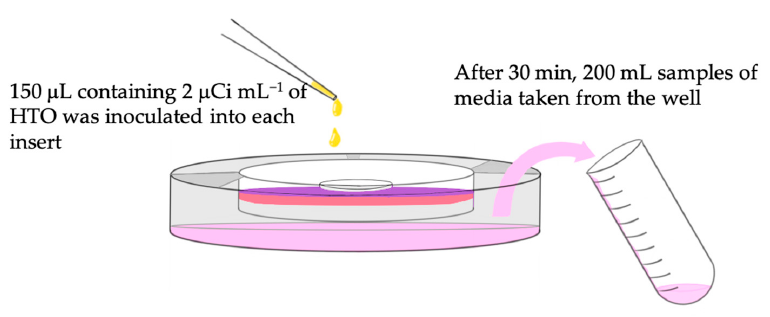
Figure 2. Schematic illustration of the procedure collecting the tritiated water